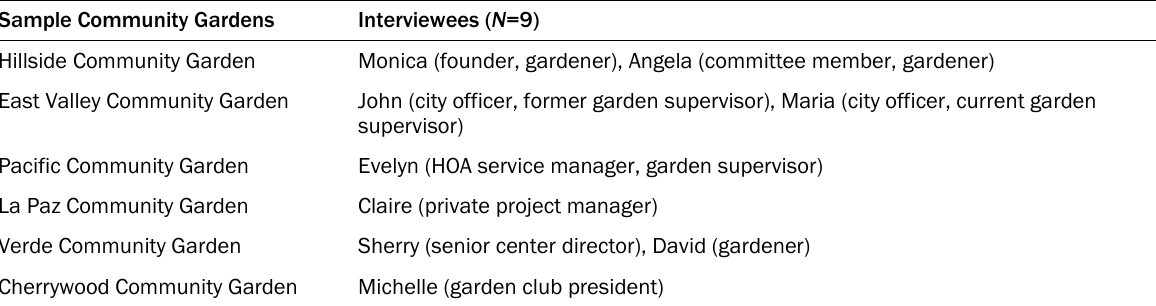
Table 2. Research Interviewees Sample Community